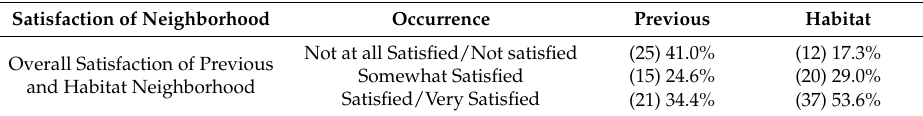
Table 9. Satisfaction of Neighborhood.